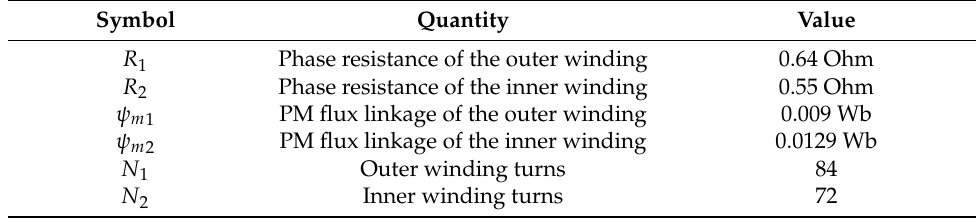
Figure 1. ( a ) The topology of the DS-PMM. ( b ) The stator and rotor assemblies of the DS-PMM prototype. Table 1. Main parameters of the inner and outer windings.